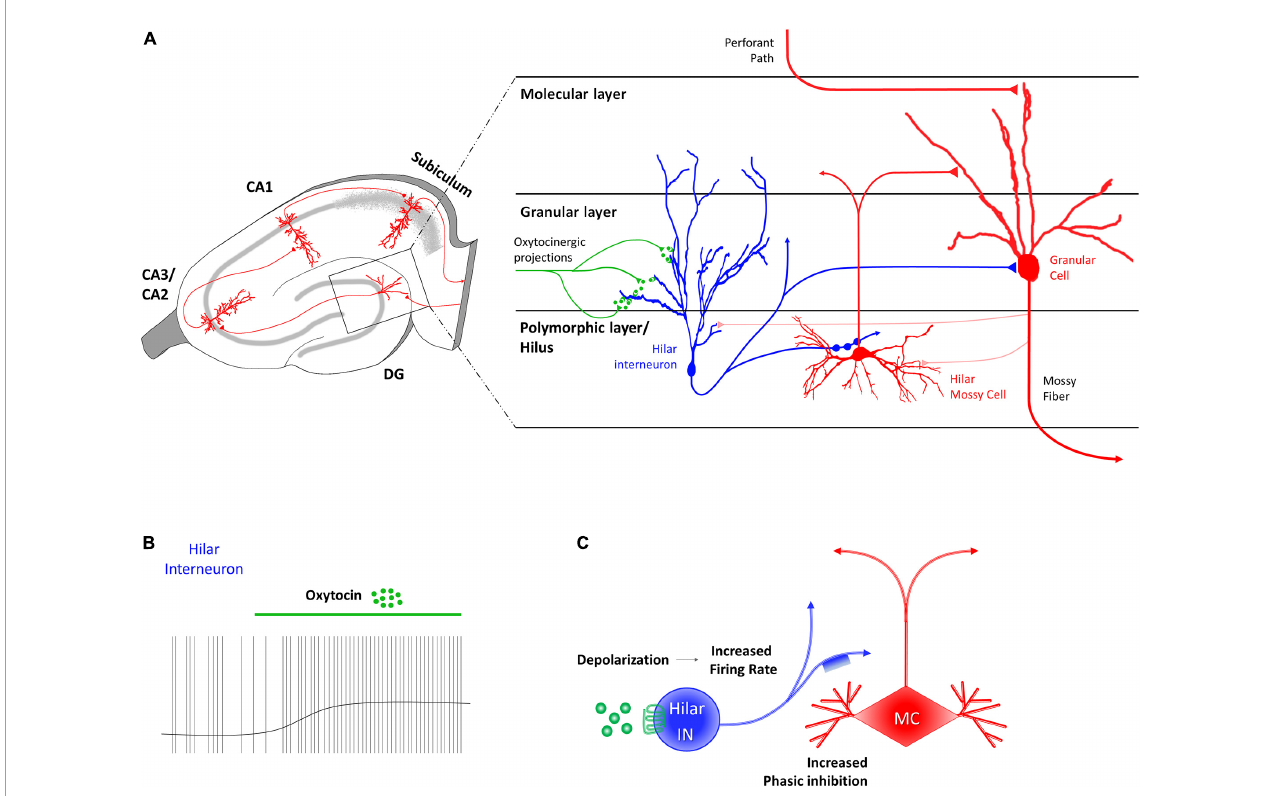
FIGURE1 Receptor distribution, oxytocinergic projections and main effects exerted by oxytocin (OT) at dentate gyrus (DG) region of the rodent’s hippocampus. (A) At the DG region, OT receptors (OTRs) are found in granular layer, on the dendrites of hilar GABAergic fast-spiking interneurons (blue). Hilar GABAergic fast-spiking interneurons, whose cell body is located in the polymorphic layer, extend axonal projects both to hilar mossy cells (red) and to granular cells (red) of the granular layer. (B) OT induces a direct and sustained depolarization of the hilar fast spiking interneurons membrane potential and a consequent increase of their firing rate. (C) The OT-dependent increased firing rate of hilar fast spiking interneurons (FS IN–blue) through the binding to OTR (green) causes indirect phasic inhibition on the glutamatergic mossy cells